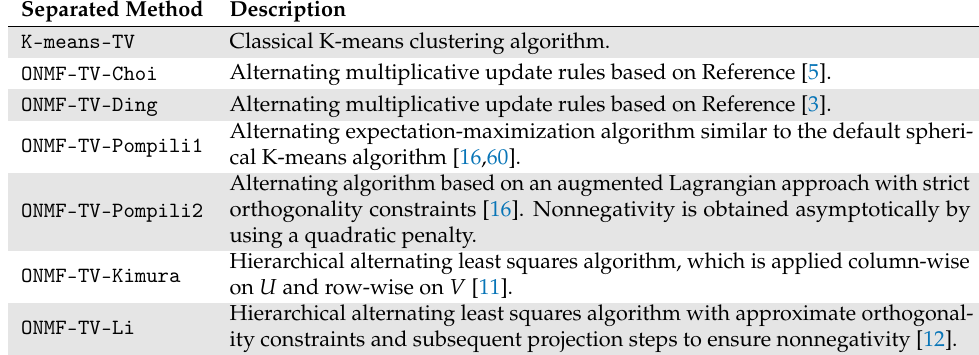
Table 1. Designations of the considered separated methods (left column) and short explanation of the corresponding ONMF algorithm (right